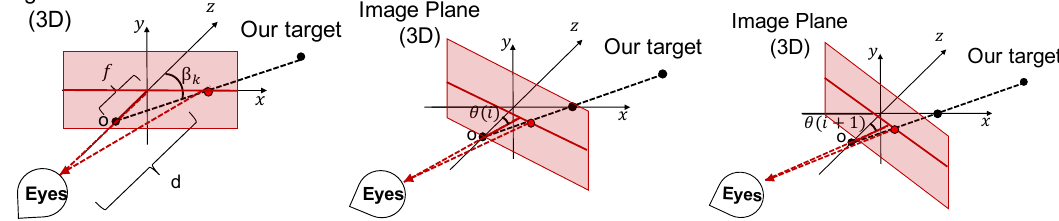
Figure 2. Images of the target object under yaw motion in 3D. Images from the left to right illustrate when the camera yaws from angle 0 (aligned with the world coordinate) to angle θ ( i ) , and to angle θ ( i + 1 ) and captures the object on the image plane. “Yaw” means the camera rotates about the y axis at the camera’s center ( o ). Images for pitch motion are similar but the camera rotates about the x axis. β is the angular object position with respect to the world coordinate and is independent of the camera motion. It is only shown in the leftmost image for clarity.